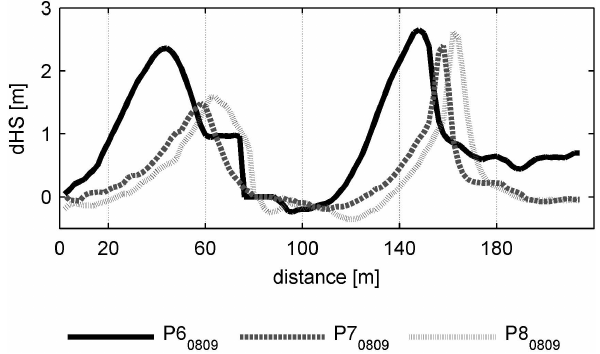
Fig. 10. Transect of measured dHS for periods 6, 7 and 8. Transect T1 is shown in Fig. 1, lowest transect. Transect crosses the cornice- like drifts in flow direction, from northwest to